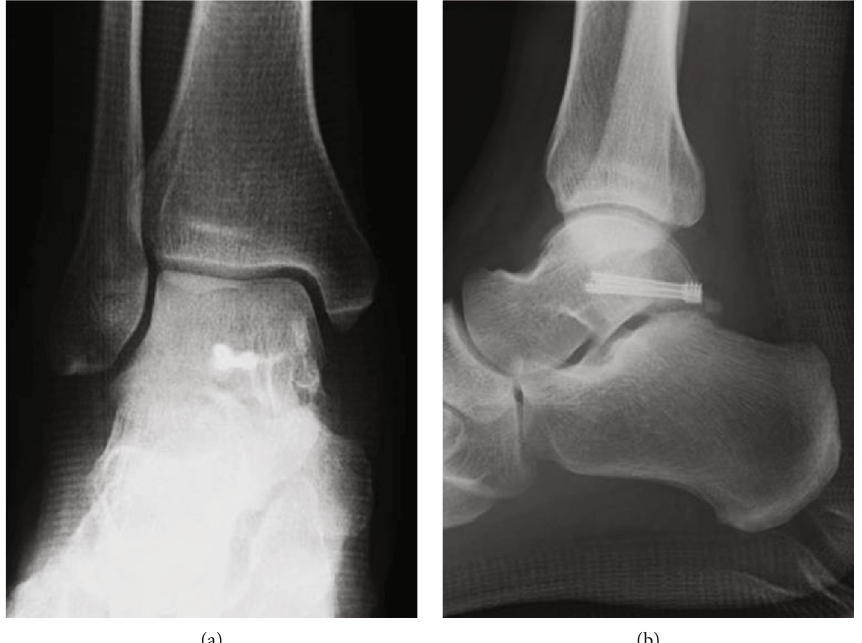
Figure 4: Postoperative plain radiograph in (a) anteroposterior and (b) lateral views showed that the fragment was reduced and fi xed with two cannulated double-threaded